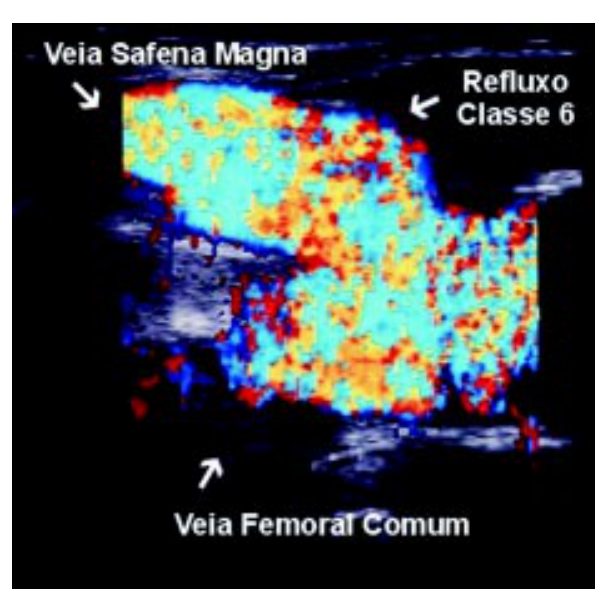
Fig 3. - Regurgitation in iliac veins and great saphenous veins.